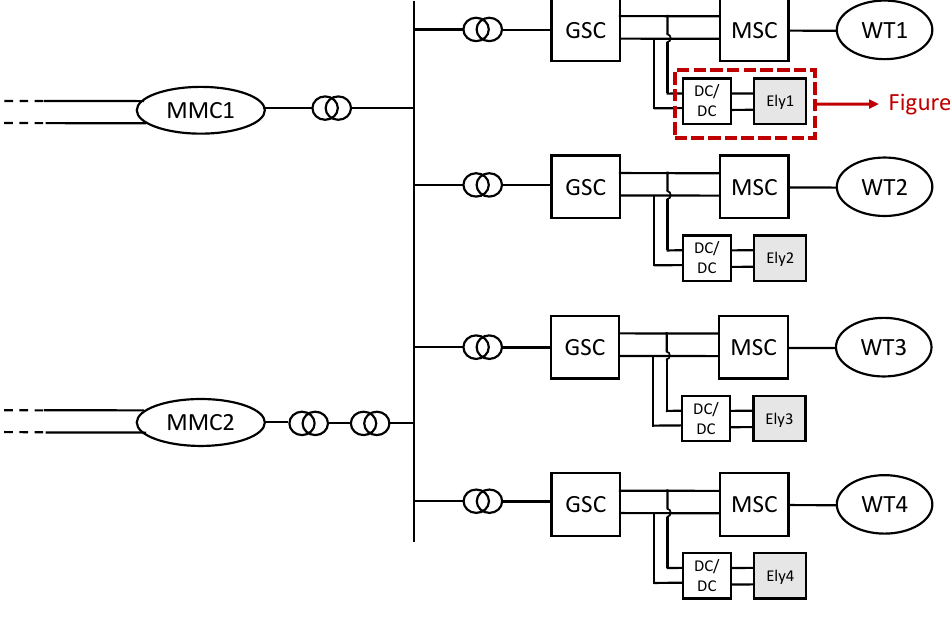
Figure 5. Hub layout in Scenario